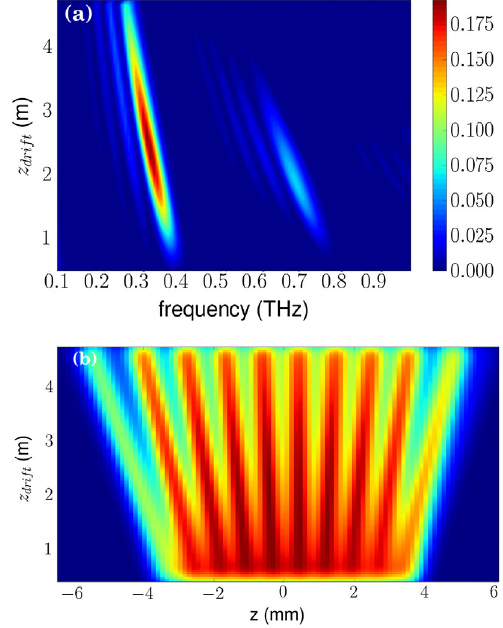
FIG. 9. Bunch form factor (BFF) (a) and bunch longitudinal density (b) evolution as a function of the drift length referenced with respect to the DLW exit. The simulations correspond to the parameters listed under the “ L -band ” column in Table I.